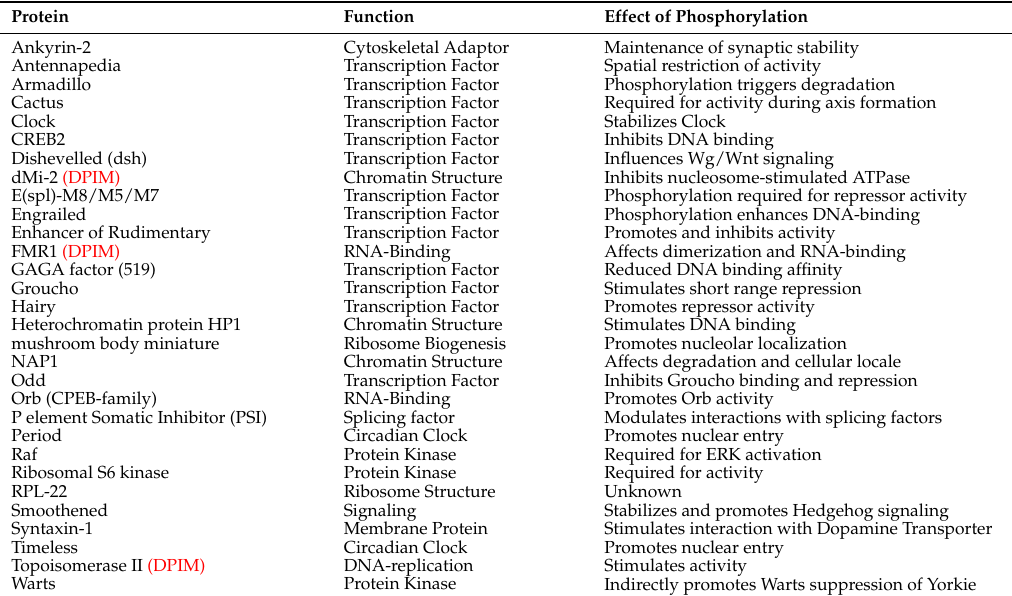
Table 1. CK2 targets from FlyBase (November